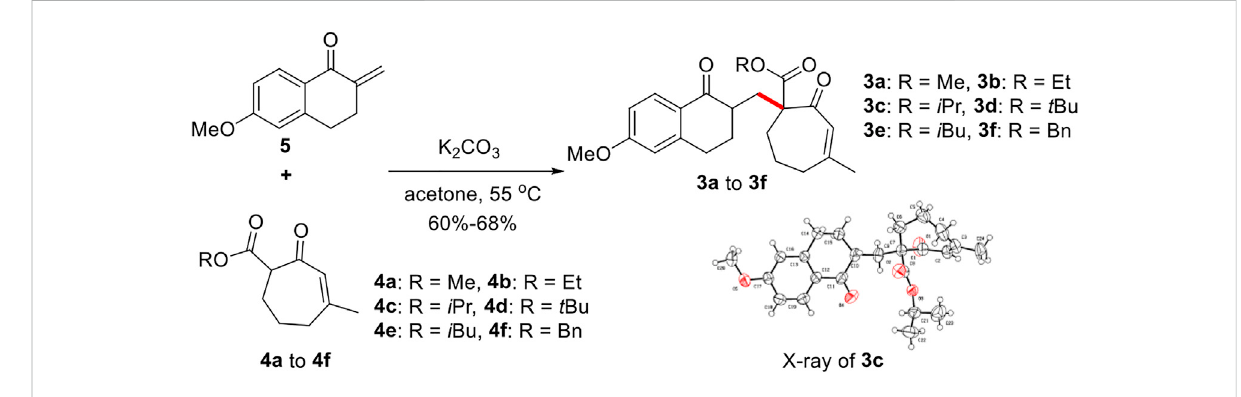
FIGURE 5 Synthesis of precursor 3.